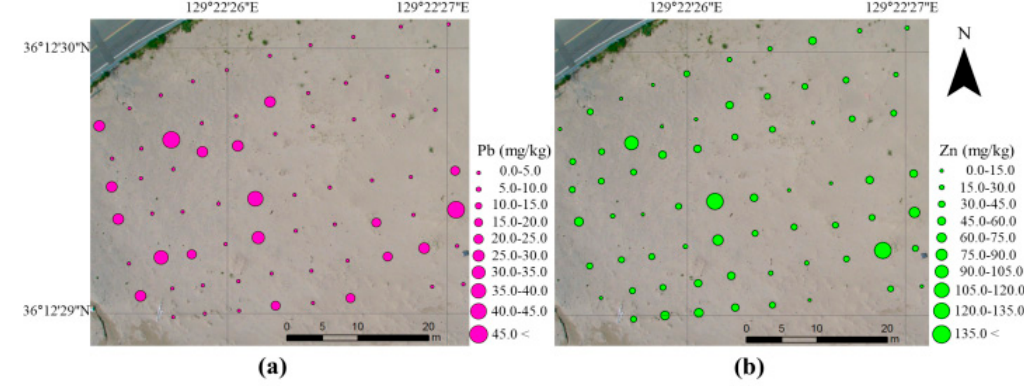
Figure 3. Spatial distributions of the concentrations of ( a ) Pb and ( b ) Zn analyzed by PXRF.